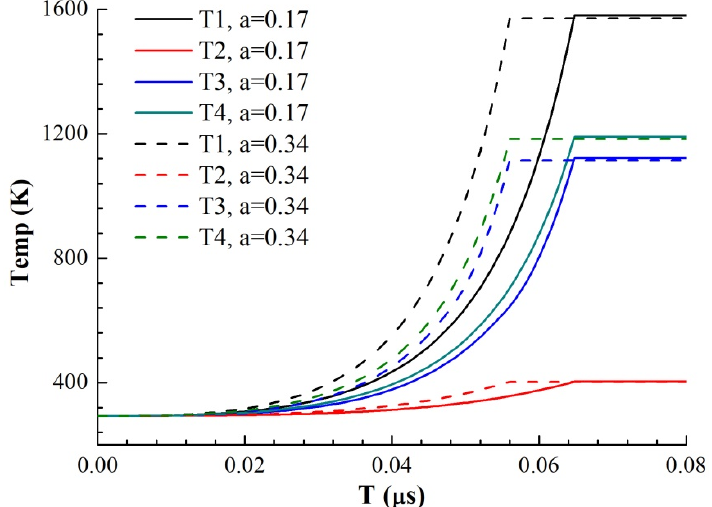
Figure 11. Simulation results of the temperature–time curve of each part of the two samples with different mixing layer thicknesses ( U 0 = 2500 V).